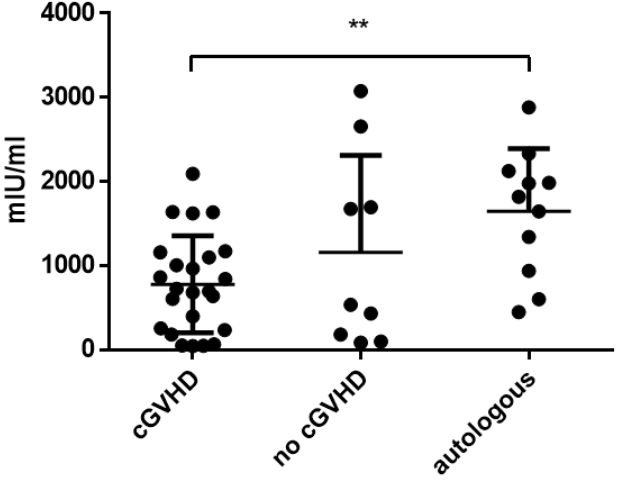
Figure 3. Mean varicella titers comparing patients with chronic GvHD vs. non-GvHD vs. autologous patients. Asterisks mark significant p -values.